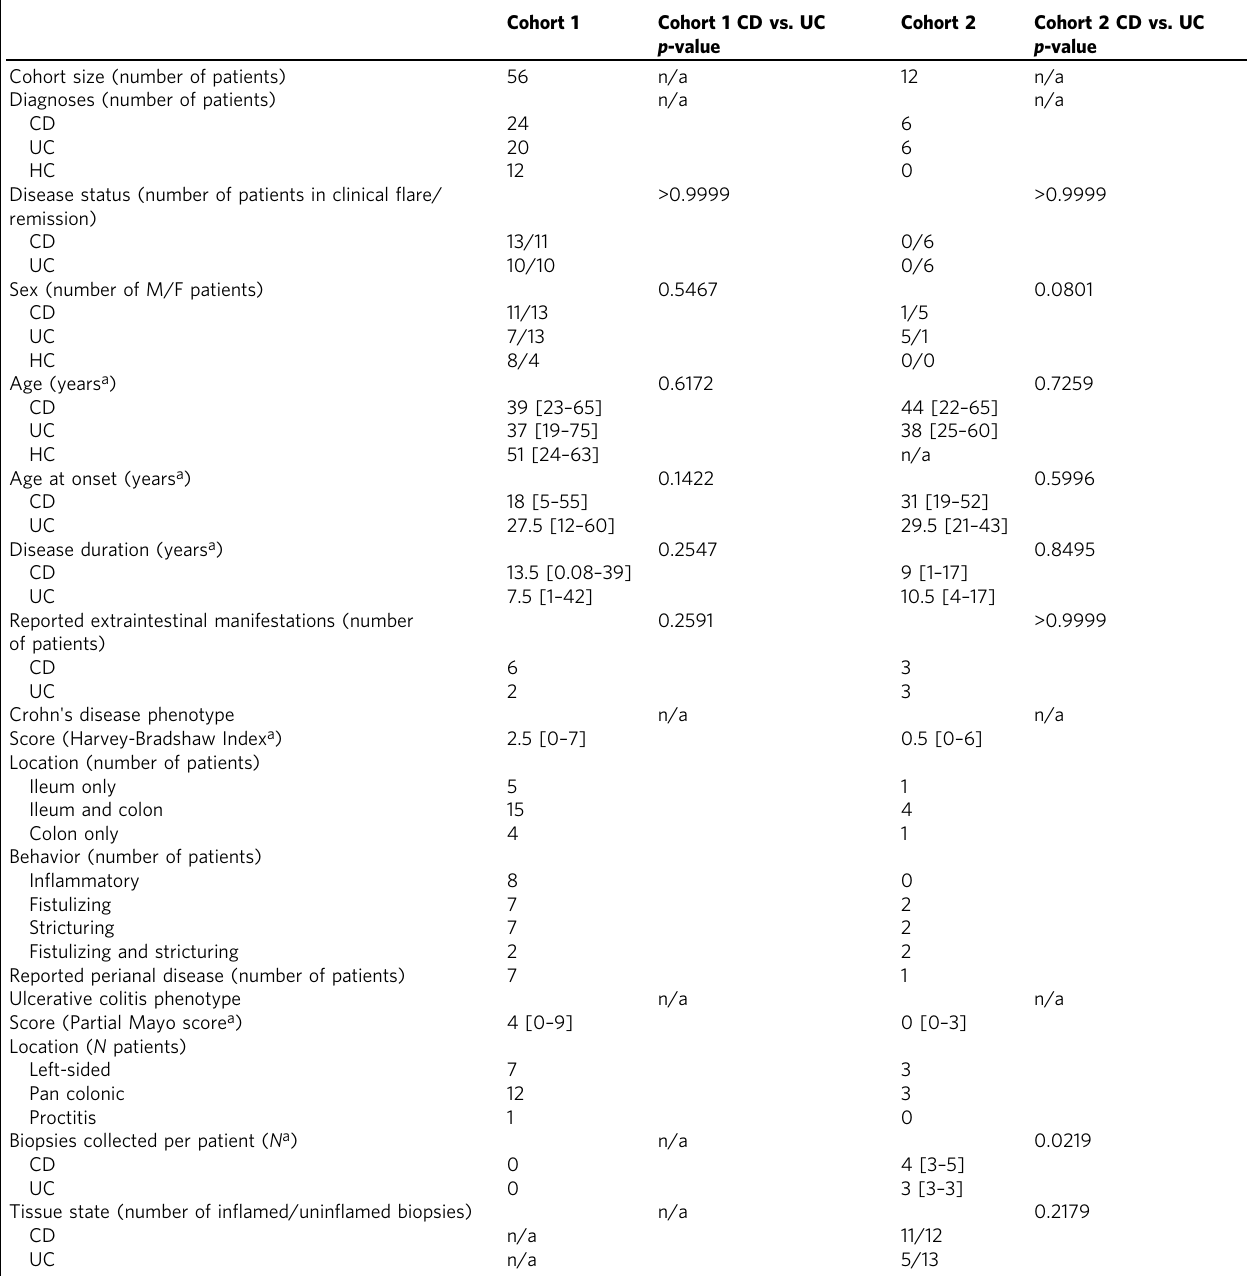
Table 1 Summary of demographic and clinical characteristics of the